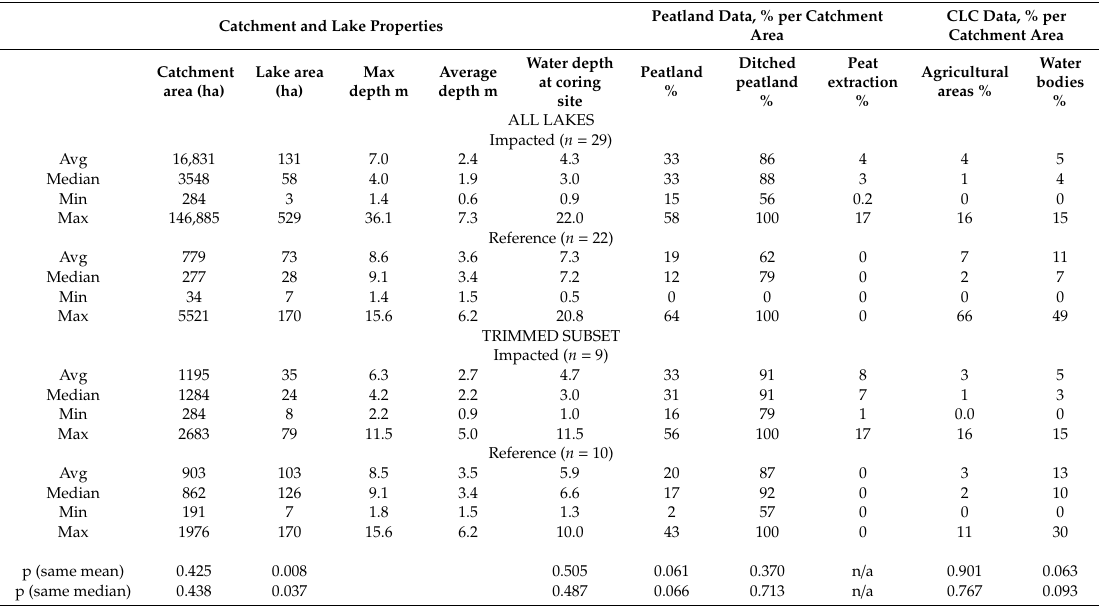
Table 1. The summary of land-use properties of catchment areas for all lakes (impacted n = 29, reference n = 22) and for the trimmed subset (impacted n = 9, reference n =